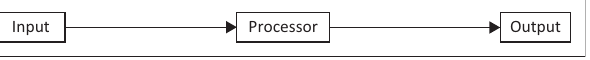
FIGURE 1: A simple system.